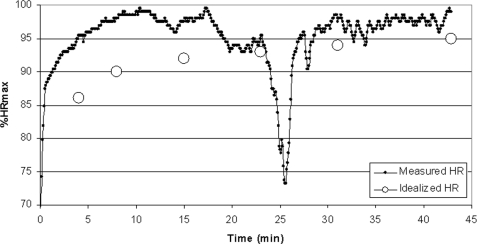
Intensity (expressed as % of maximal heart rate, %HRmax) versus time curve of an elite runner who started a 12-km cross-country race too fast, slowed to a walk in mid race, and then continued the race.It is contrasted to an idealized curve for this distance (based on the data in Figure 1). Abbreviations: HR (heart rate).